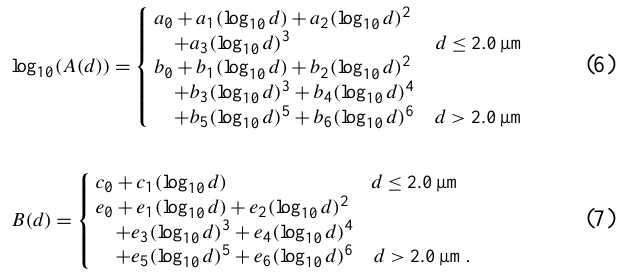
panel that both the slope of the regression lines ( B(d)) and its y intercept (log 10 A(d)) may vary with aerosol particle di- ameter. Note, however, that the y intercept does not cross the y axis shown in Fig. 2b because the actual R value instead of log 10 (R) is used for the x axis. But according to Eq. (4), A(d) equals 3 rain ( d , 1) (i.e., when R = 1 . 0 mm h − 1 ) , so A(d) val- ues are also readily available. The resulting A(d) and B(d) values are plotted in Fig. 2c and d, respectively, for each of 100 aerosol particle